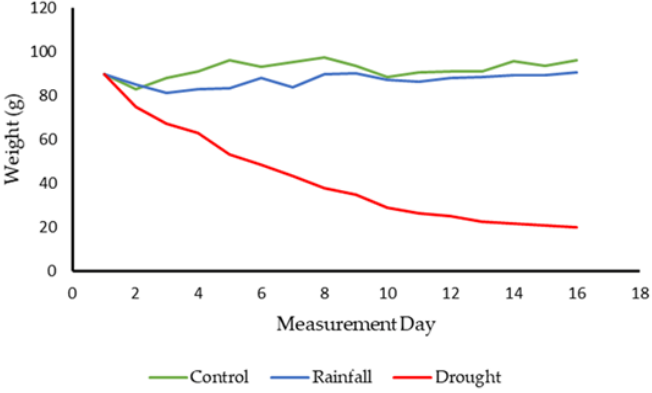
Figure 11. Visual change to redder pigmentation observed in all groups as a result of a change to colder conditions shown alongside hyperspectral image frames taken from red wavelengths, clearly demonstrating the observed change. Example taken from a control group sample.